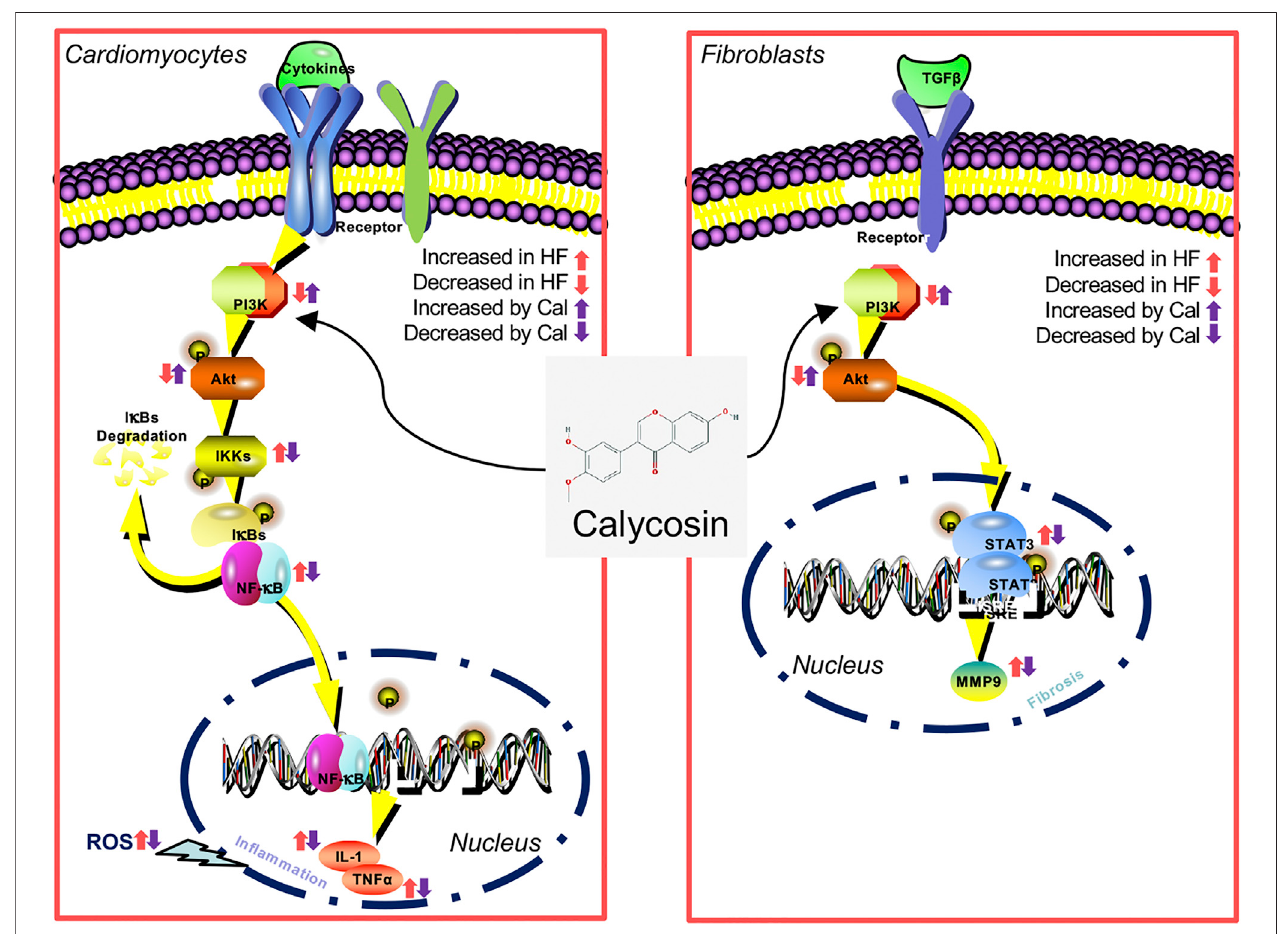
FIGURE 7 | A diagram of the involvement of PI3K – AKT in the inhibition by Cal of cardiac in fl ammation and fi brosis induced by myocardial infarction (MI).